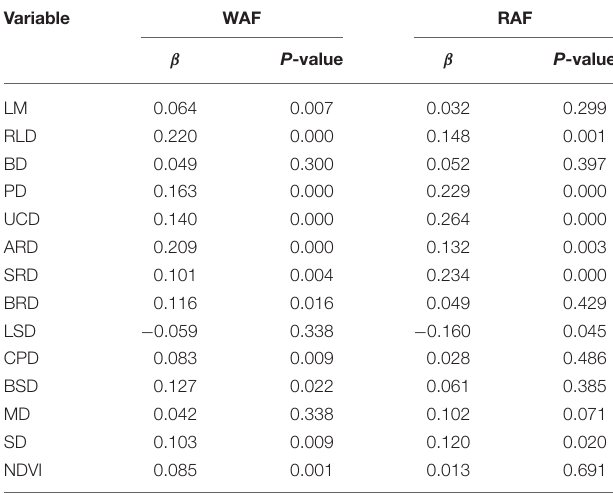
TABLE 4 | The results of MLR-LT regarding WAF and